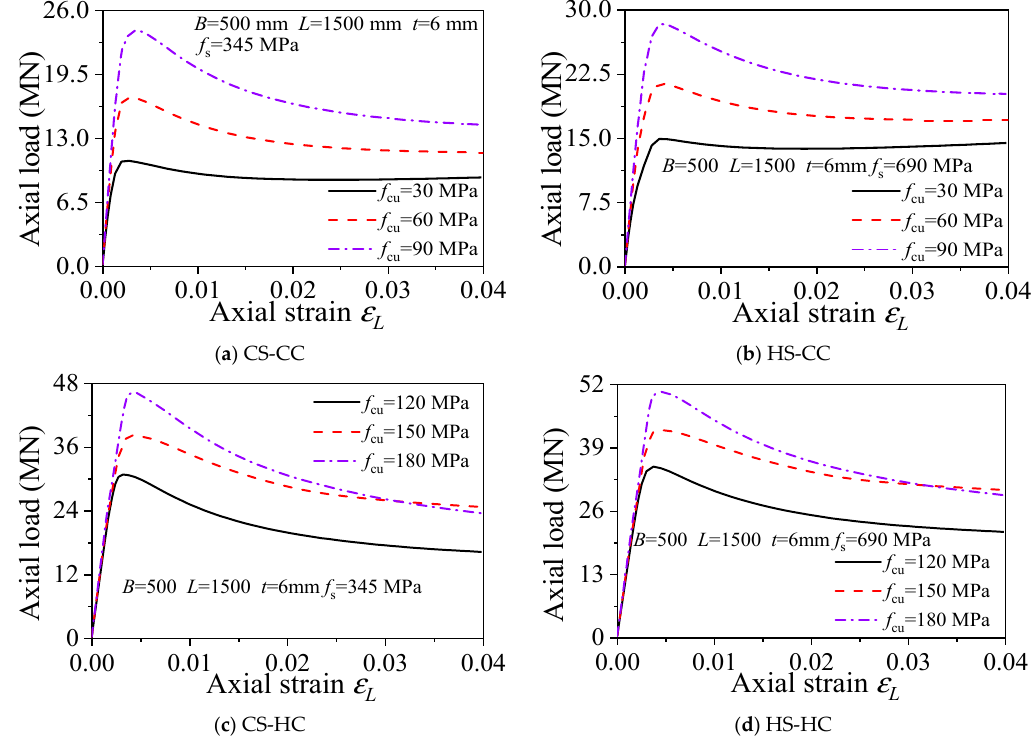
Figure 6. Influence of concrete strength on the load–strain curve.